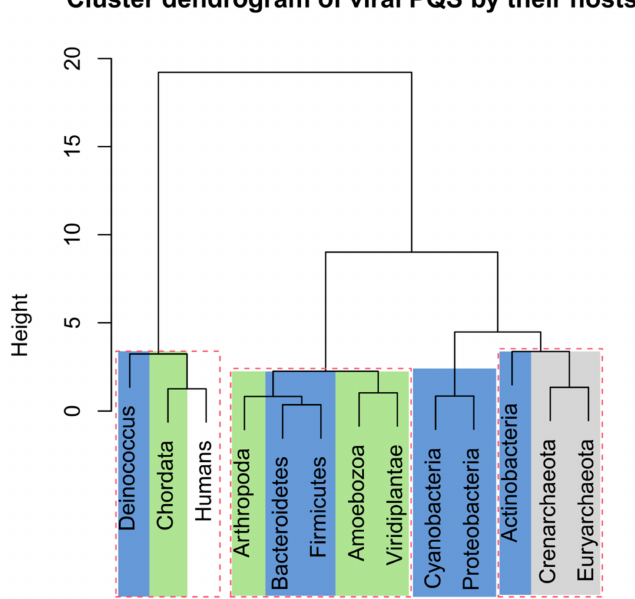
Figure 3. Cluster dendrogram based on PQS characteristics in all viral species by their host. Input data are listed in Supplementary Materials S4. Statistically significant clusters (based upon approximately unbiased p -values above 95, equivalent to p -values lower than 0.05) are highlighted by rectangles drawn with broken red lines. The colors correspond to phylogenetic tree